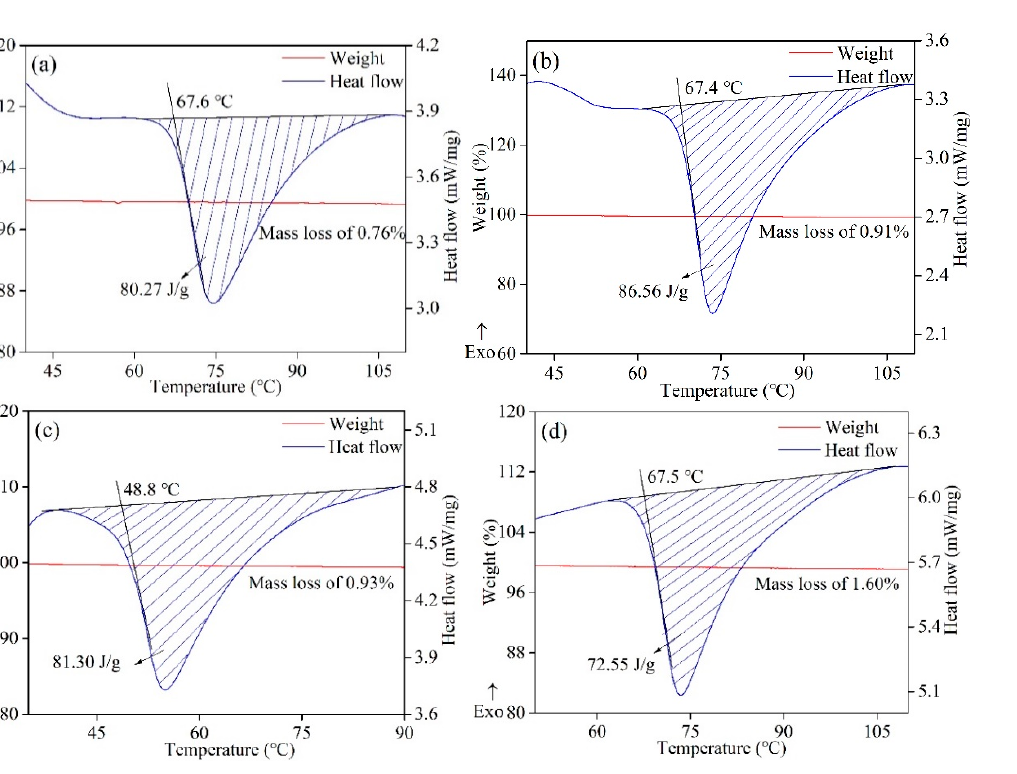
Figure 3. Thermal analysis curves of the PA/gypsum and TC/PA/gypsum composites. ( a ) PA/gypsum composites; ( b ) PA/gypsum composites with 8 wt.% iron powder; ( c ) PA/gypsum composites with 8 wt.% copper powder; and ( d ) PA/gypsum composites with 8 wt.%